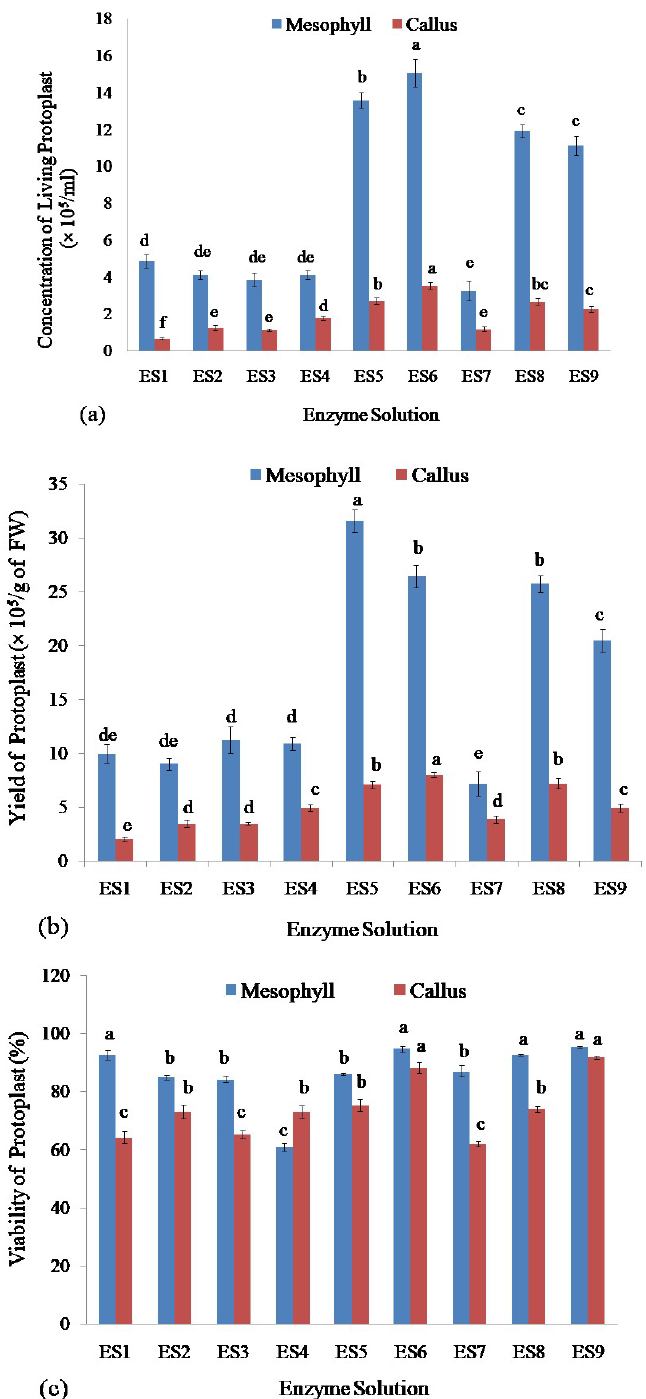
Figure 3. Assessment of protoplasts isolated from leaf mesophyll and callus of stevia by using different concentrations of cellulase R-10 and macerozyme R-10 enzyme solutions: ( a ) Comparison of concentration of isolated living protoplasts; ( b ) Assessment of yield; and ( c ) Viability of protoplasts. Bars denoted the mean of three measurements per treatment ± SE (Standard Error). Mean values with the same letters are not significantly different based on the student’s t -test at p = 0.05 .